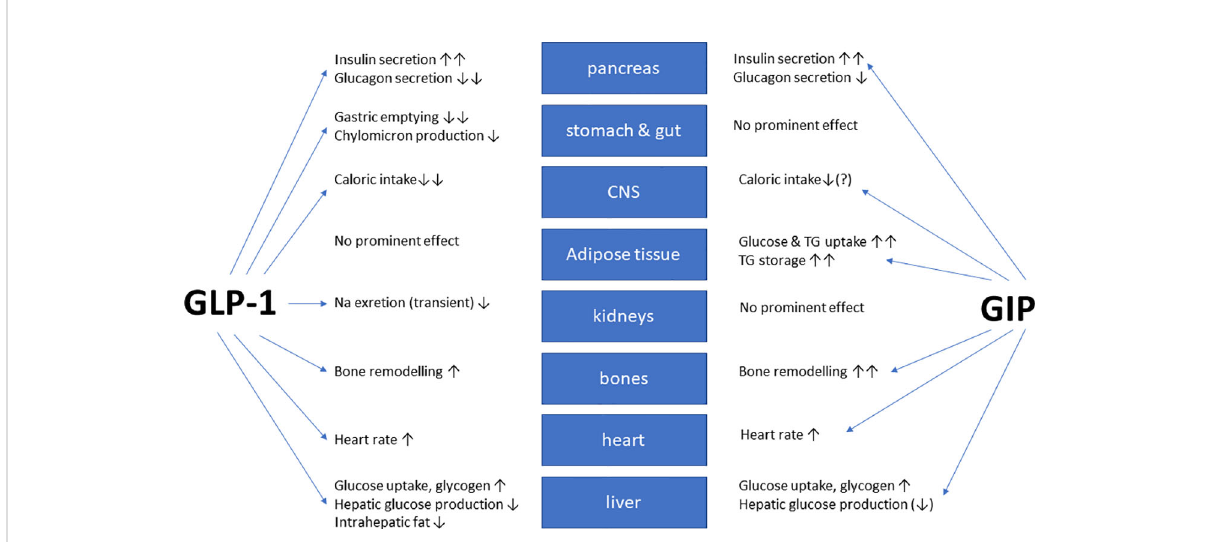
FIGURE 1 Overview of the biological glucose-dependent insulinotropic polypeptide (GIP) and glucagon-like peptide-1 (GLP-1) effects at the organ/tissue level (modi fi ed from (47)). The blue arrows depict relevant physiological